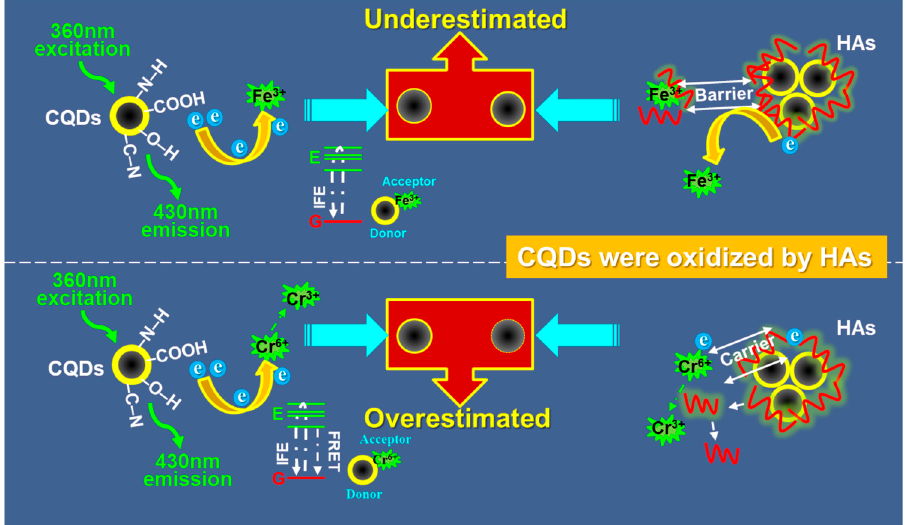
Figure 5. Schematic diagram of the mechanisms that humic acids (HAs) interfered with the detec- tion of Fe 3+ and Cr 6+ ions by the cyanobacteria carbon quantum dots (CQDs). E—Excited-state, G—Ground-state, IFE—internal filtering effects, FRET—fluorescence resonance energy transfer.